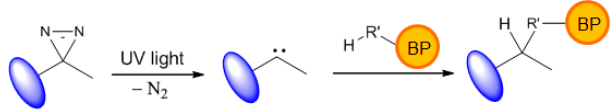
Figure 5. Diazirine reaction scheme for UV-induced photochemical conjugation. BP represents the binding proteins.